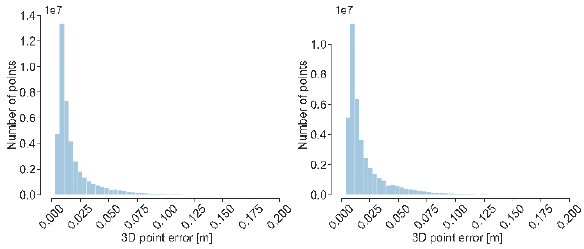
Figure 3. Histogram for the 3D point error ( pe ) in the rectangular test site subset for the 2018 point cloud (left) and the 2019 point cloud (right).